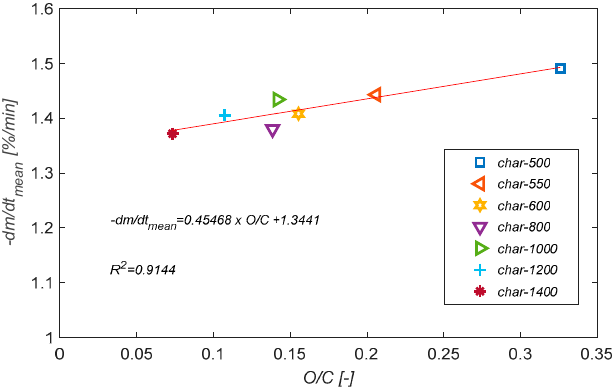
Figure 11. Mean mass loss rate of the char in the TG air oxidation experiments as a function of O/C atomic ratio.